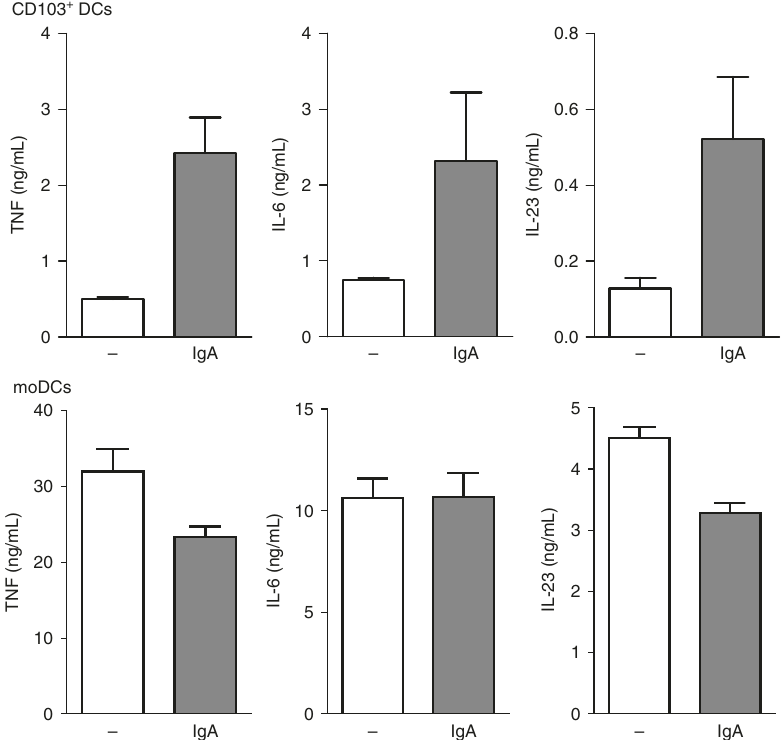
Fig. 1 IgA opsonization of bacteria enhances production of proin fl ammatory cytokines by CD103 + DCs. CD103 + dendritic cells (DC) or moDCs were stimulated with 10 MOI S. aureus , which were untreated or opsonized with 5 mg/mL serum IgA for 1 h and washed. Experiments were performed in triplicate. After 24 h cytokine levels were analysed using ELISA, mean + s.e.m. Representative example of three experiments with different